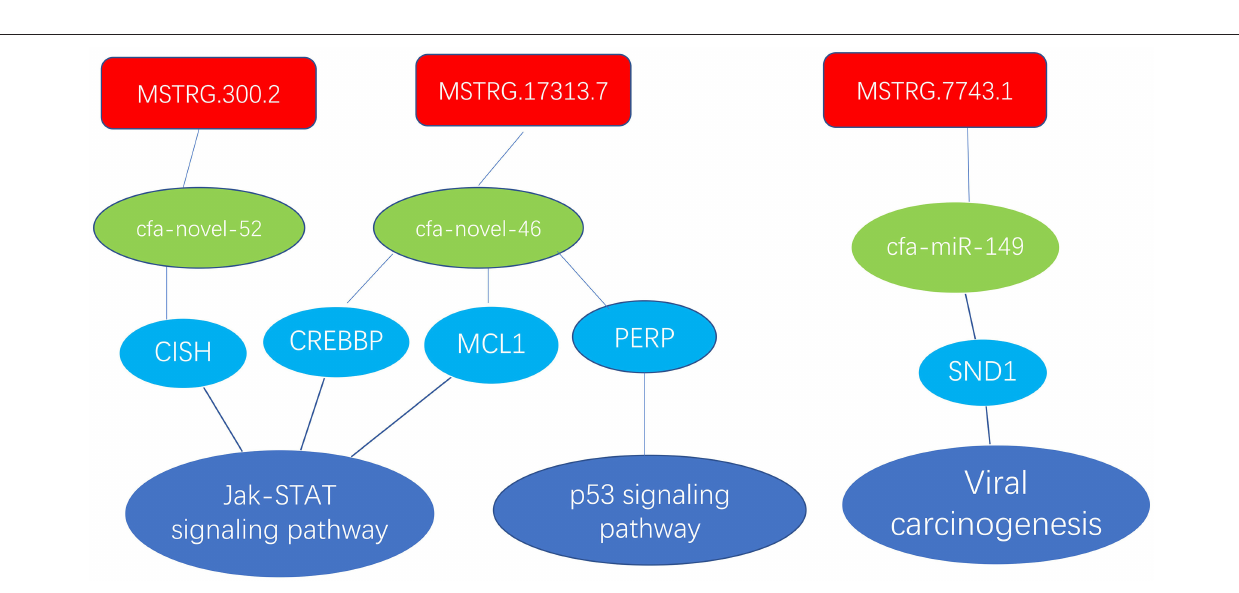
Frontiers in Cellular and Infection Microbiology |